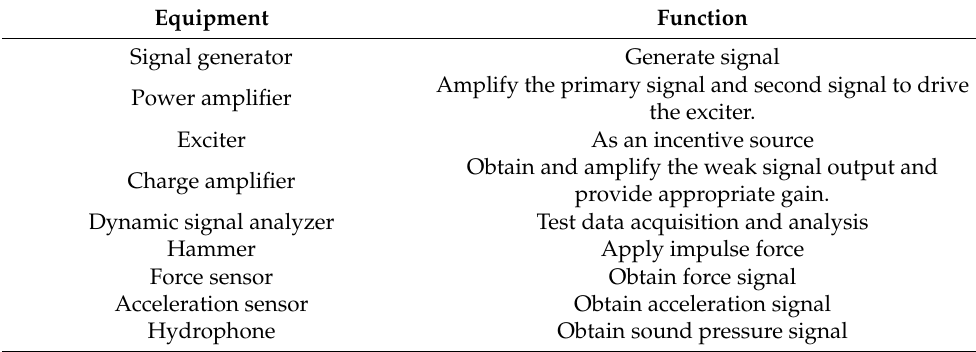
Table 4. Main testing equipment and function.